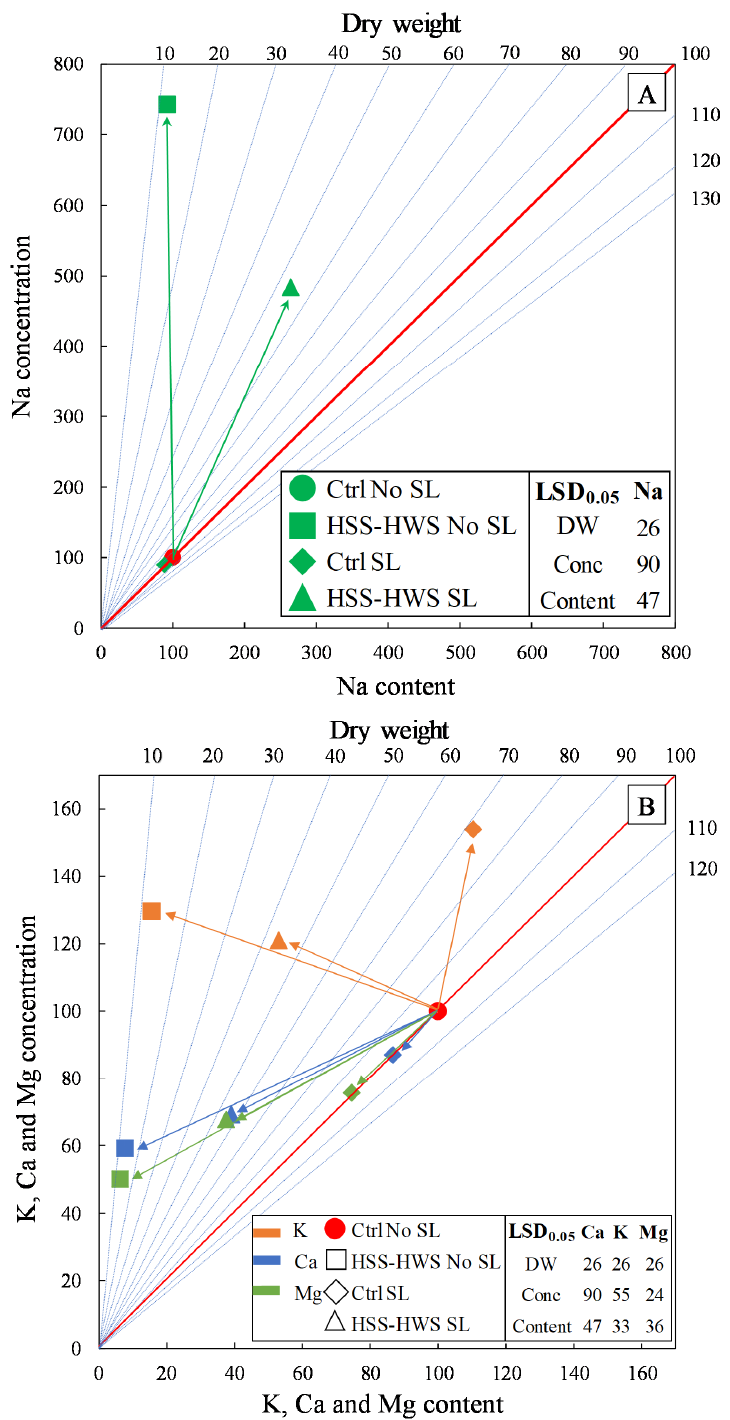
Figure 4. ( A ) Vector analysis showing directional changes in biomass and Na content and concentration in sorghum plants and, ( B ) vector analysis showing directional changes in relative biomass and K, Ca, and Mg content and concentration in sorghum plants. Dry weight and element content and concentration are expressed as relative data with respect to the Ctrl No SL treatment, which is set at 100% and is indicated by a red filled circle.